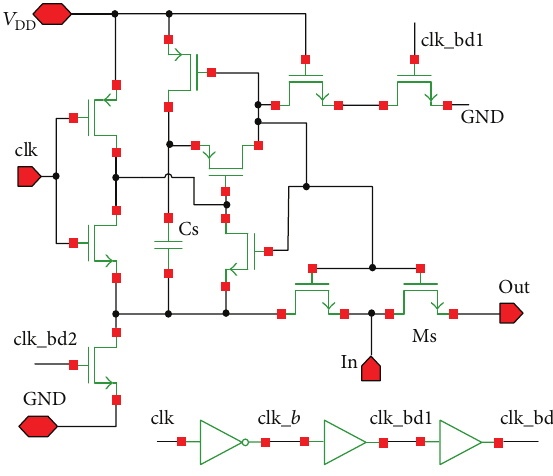
Figure 9: Schematic of track and hold block.